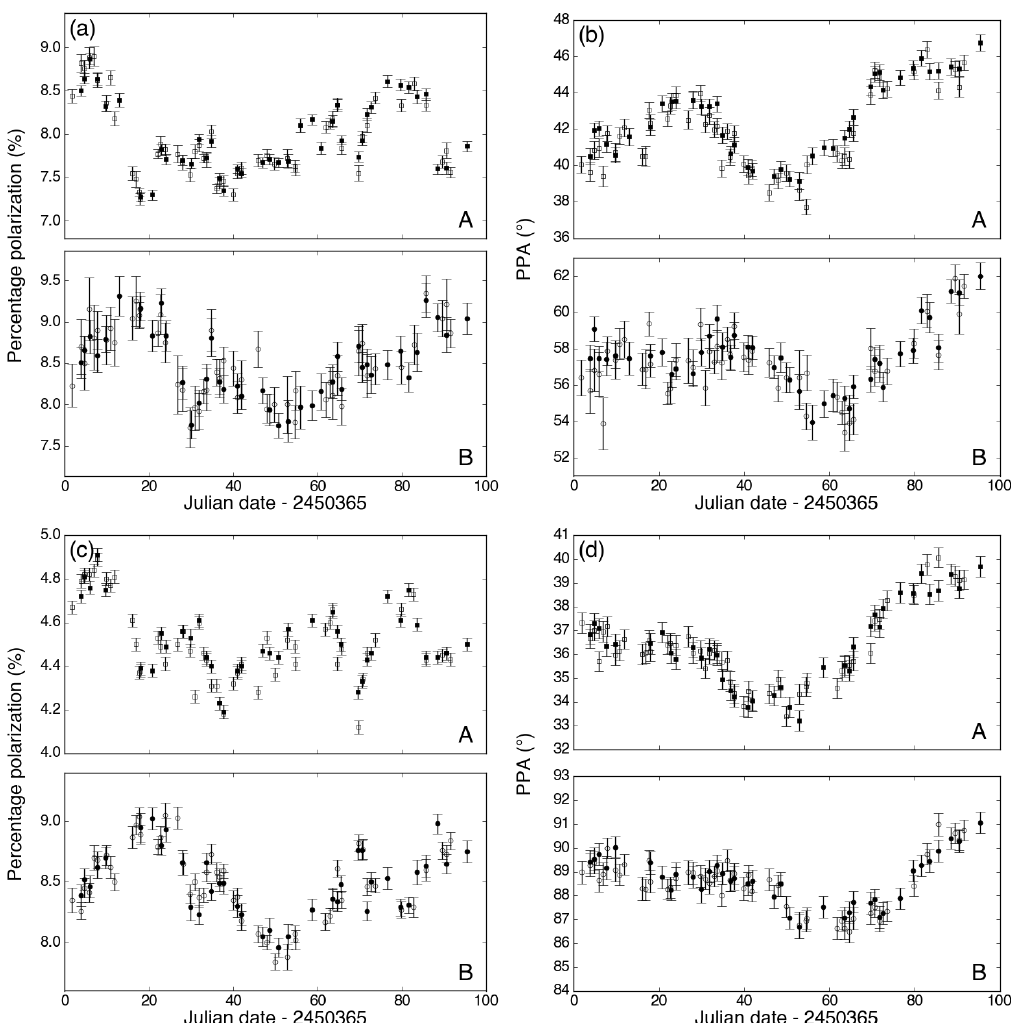
Figure 3. Variability curves of images A and B of B0218+357. ( a ) 15-GHz percentage polarization; ( b ) 15-GHz polarization position angle; ( c ) 8.4-GHz percentage polarization; ( d ) 8.4-GHz polarization position angle. Image A is the upper panel in each